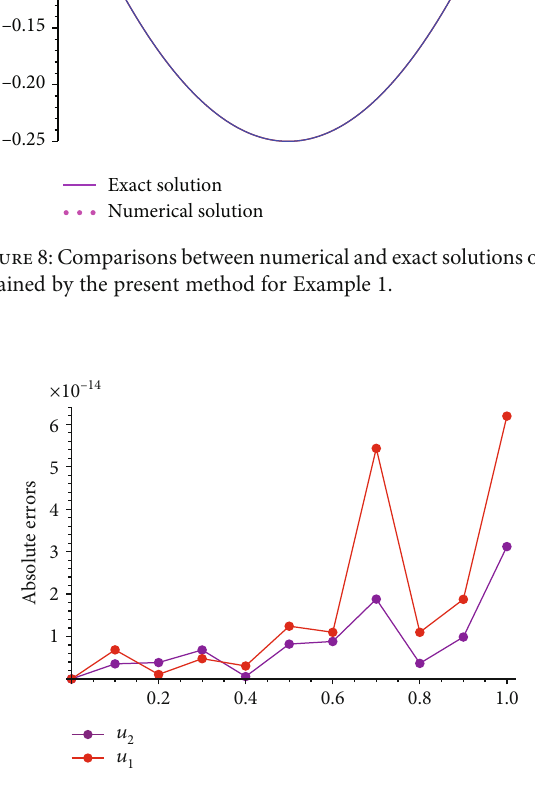
Figure 9: Absolute errors of u method for Example 1.